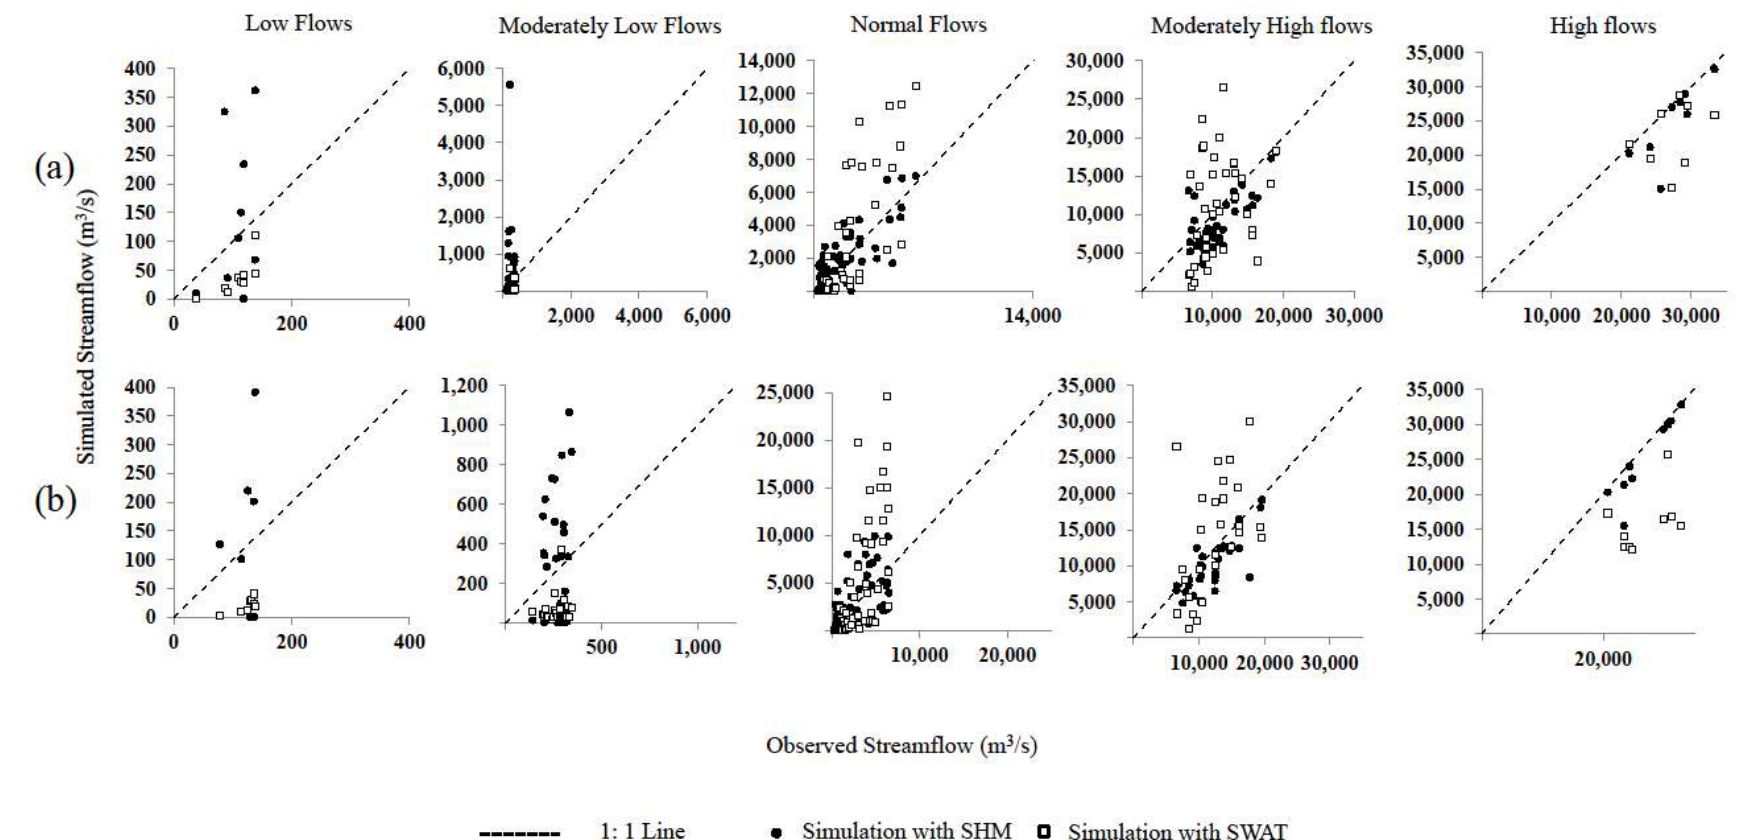
Figure 5. Comparison between observed and models’ simulated five streamflow quantile ranges during ( a ) calibration period and ( b ) validation period.